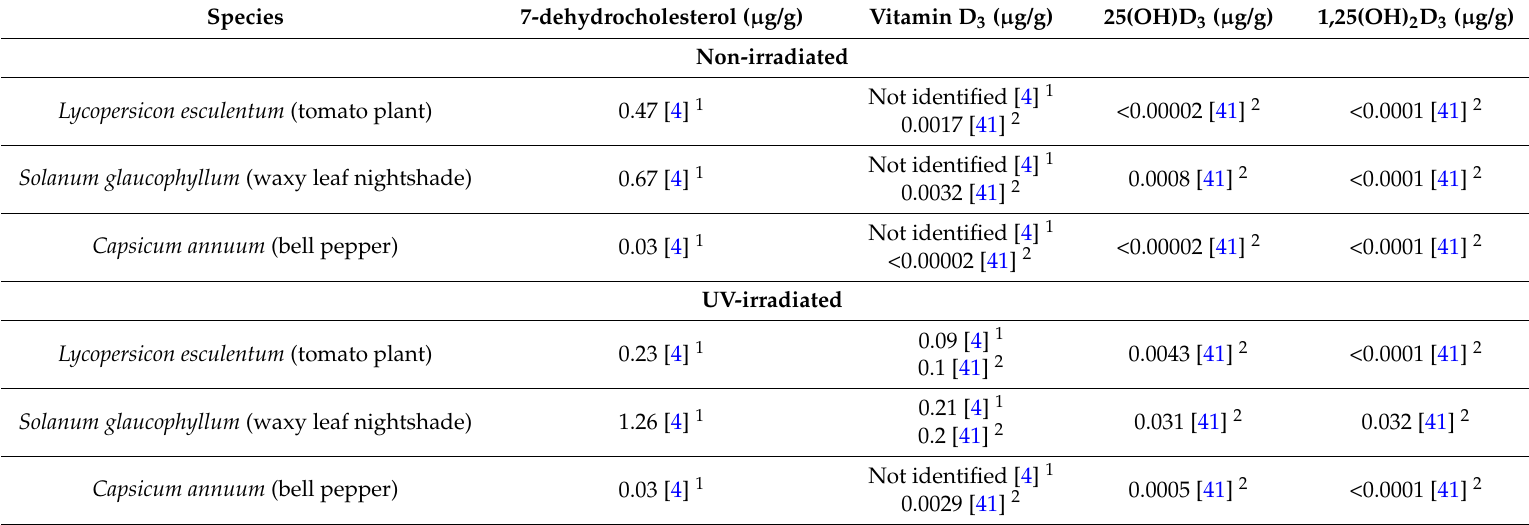
Table 1. Concentrations of vitamin D 3 metabolites (dry weight) in plant leaves from the Solanaceae family, measured by liquid chromatography tandem mass